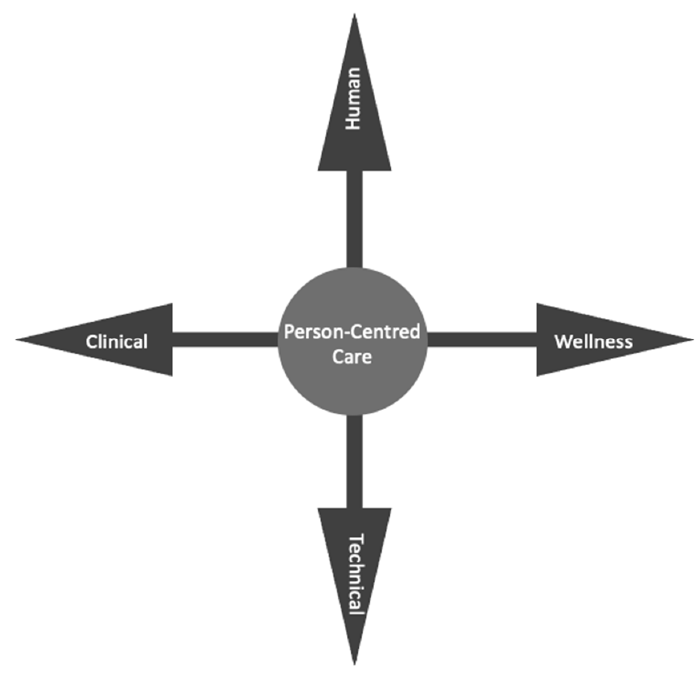
Figure 3. Layer 2a: Human and technical continuum (vertical axis). Layer 2b: Clinical and wellness continuum (horizontal axis) form a Cartesian plane scatter box plot graphing tool.